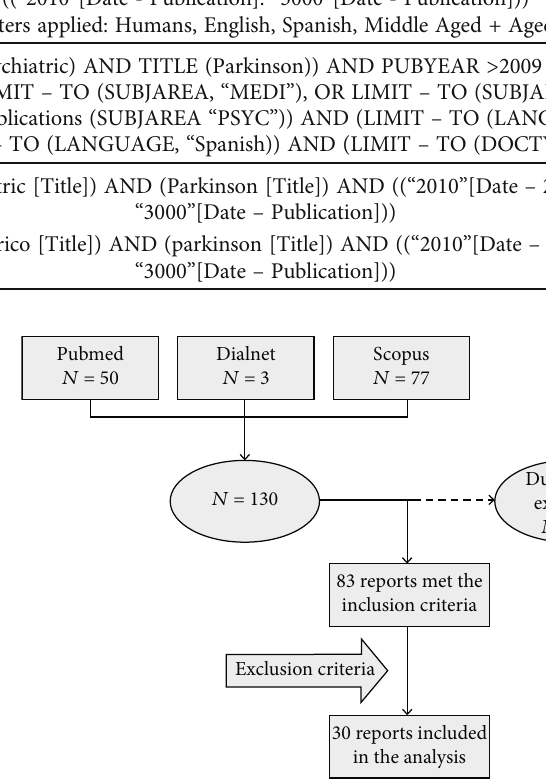
Table 4. The mean PD patient age was 66 : 2 ± 8 : 8 years, 67.3% were male, and the average duration since diagnosis